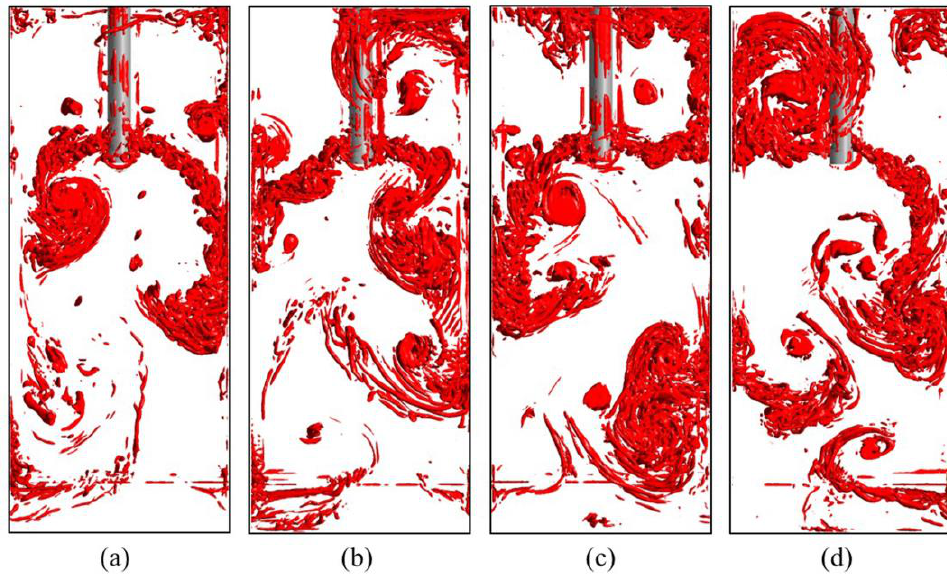
Figure 6. Instantaneous iso-surfaces of Q-criterion for the case applying EMBr with electrically-insulated walls at: ( a ) 14 s; ( b ) 16 s; ( c ) 18 s; ( d ) 20 s.